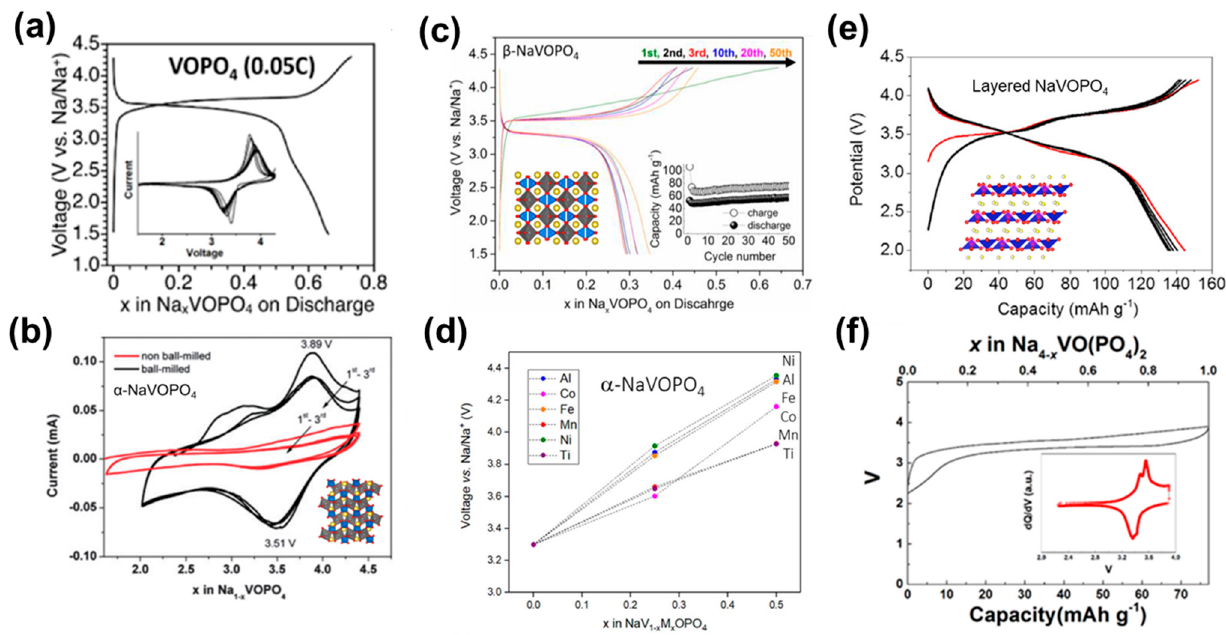
Figure 3. ( a ) Typical charge–discharge curves and CV (inset) between 1.5–4.3 V of the layered VOPO 4 electrodes [25]. ( b ) CV profiles (scan rate at 0.1 mV s − 1 ) and crystal structure of α -NaVOPO 4 [73]. ( c ) Charge–discharge curves of β -VOPO 4 at C/20 (8 mA g − 1 ) between 4.3 and 1.5 V. Insets show the crystal structure and cycling capacities [74]. ( d ) How the type and concentration of dopants on the V site influence the cell voltage (vs. Na + /Na) in the α -NaVOPO 4 polymorphs (M = Al 3+ , Co 2+ , Fe 3+ , Mn 4+ , Ni 2+ , or Ti 4+ ) [75]. ( e ) Lattice structure and galvanostatic charge–discharge profiles of the layered NaVOPO 4 electrode at a current rate of 0.05 C (1 C = 145 mA g − 1 ) [28]. ( f ) Charge/discharge curve of Na 4 VO(PO 4 ) 2 . Inset is dQ/dV [29].